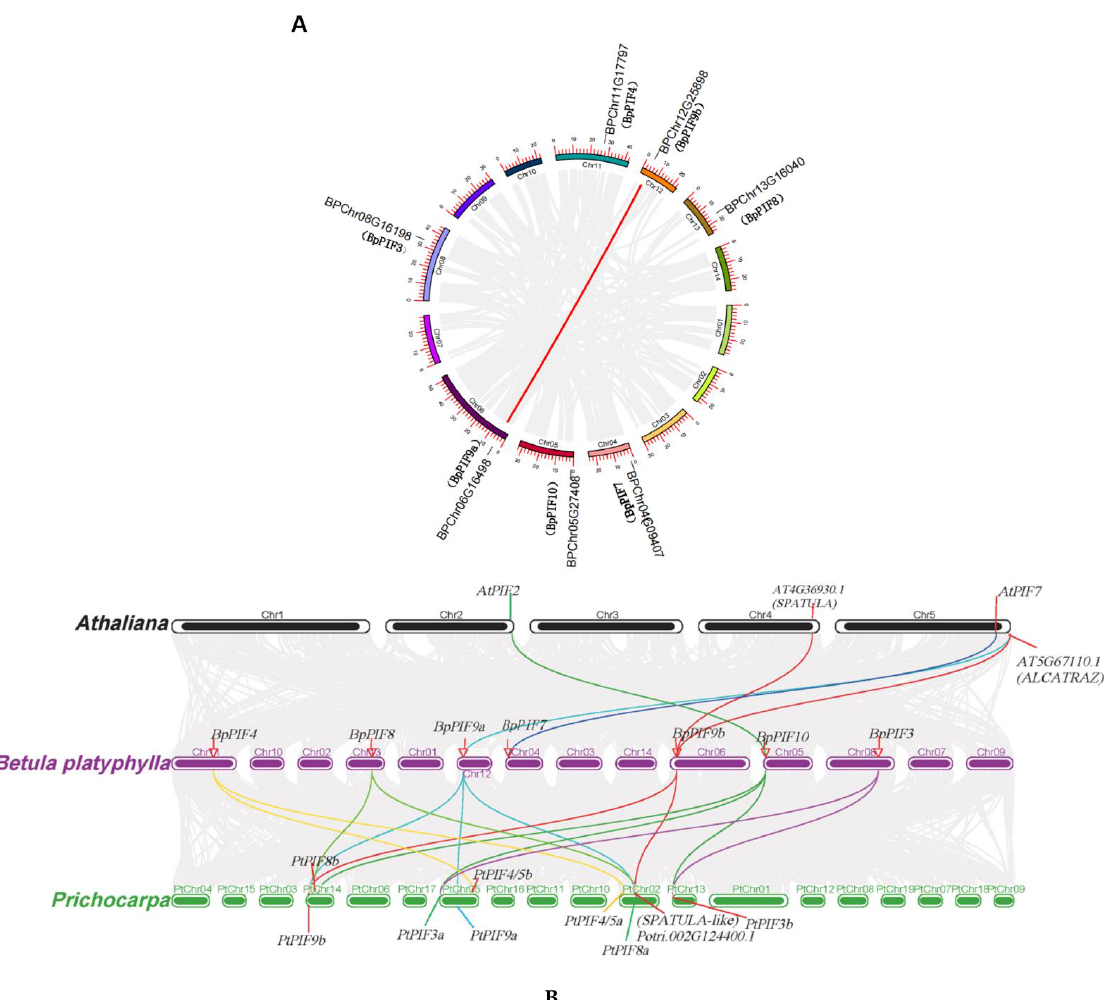
Figure 3. Gene duplication and synteny analysis of BpPIF genes. ( A ) Schematic representations for the chromosomal distribution and interchromosomal relationships of BpPIF genes. Grey lines indicate all synteny blocks in the Betula platyphylla Suk . Genome, and the red lines indicate segmental duplicated BpPIF gene pairs. ( B ) Synteny analysis of BpPIF genes between Betula platyphylla , Arabidopsis thaliana , and Populus trichocarpa . Grey lines in the background indicate the collinear blocks within Betula, Arabidopsis, and Populus genomes, while the red lines highlight the syntenic BpPIF gene pairs. Lines with different colours highlight different gene pairs.